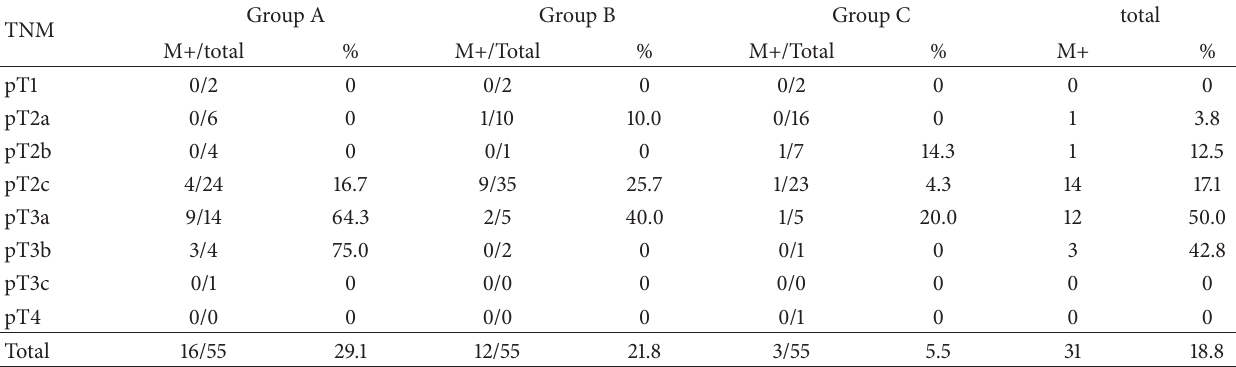
Table 2: Positive margins versus stage of the